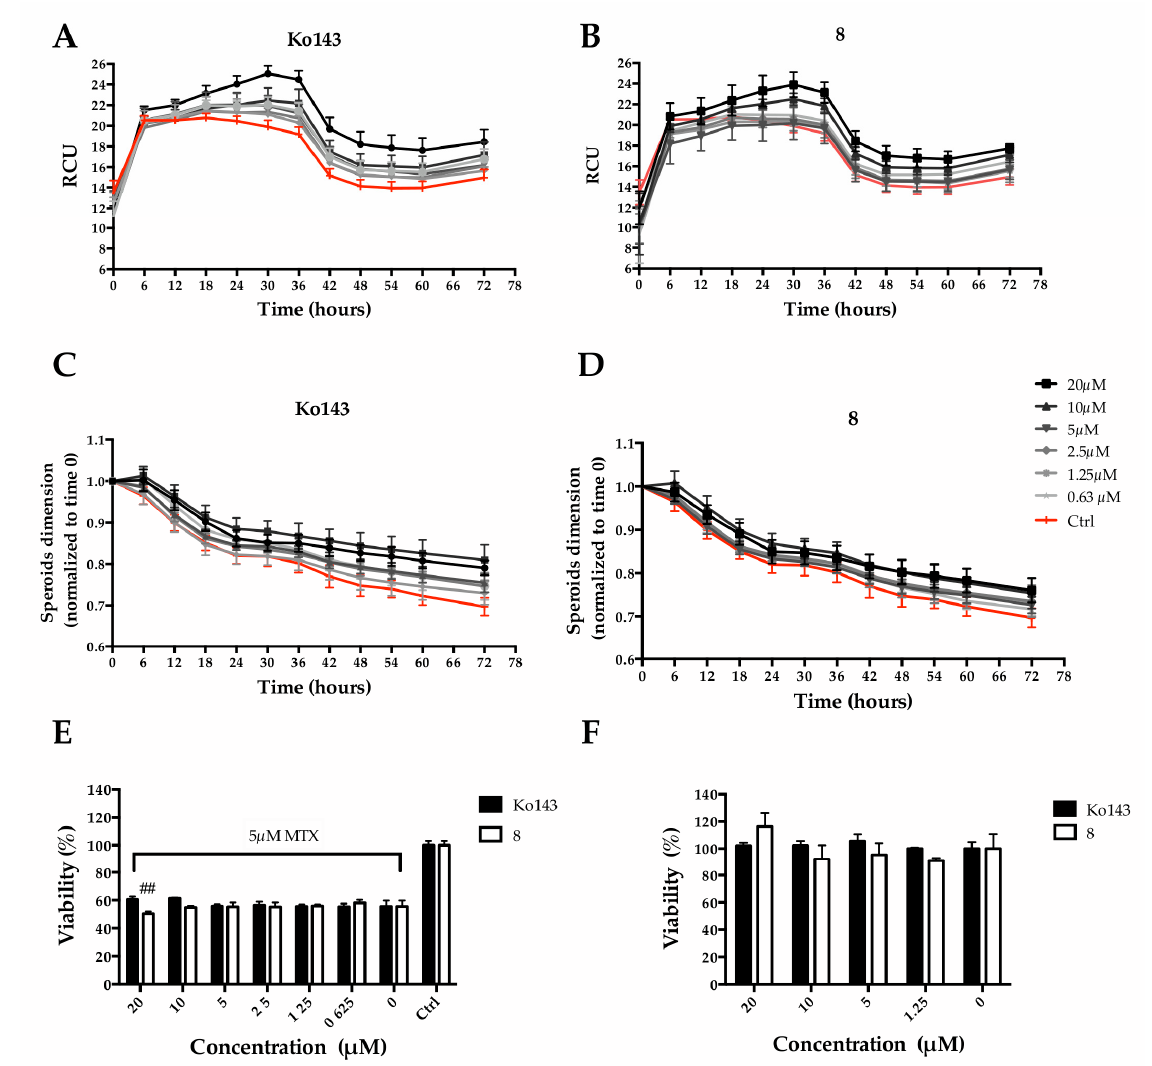
Figure 9. Effect of 8 or Ko143 on MTX uptake in Hep G2 spheroids. Spheroids were pre-treated (2 h) with Ko143 or alternatively with 8 at different concentrations (i.e., 20, 10, 5, 2.5, 1.25 and 0.625 μ M) and then treated with MTX at a final concentration of 5 μ M. Spheroid size was calculated through Incucyte ® Zoom Software (v2021 ) after pre-treatment with Ko143 ( A ) or 8 ( B ). Fluorescence intensity time course acquired with Incucyte ® for 72 h after mitoxantrone treatment with Ko143 ( C ) or 8 ( D ). Spheroid viability 72 h after treatment with ( E ) and without ( F ) MTX expressed as a per- centage of resazurin reduction compared to the ctrl. ## denotes p < 0.01 vs. MTX alone.